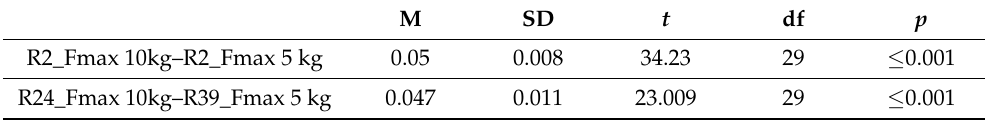
Table 6. Paired-samples test for initial and final repetition for 10 kg and 5 kg, respectively.